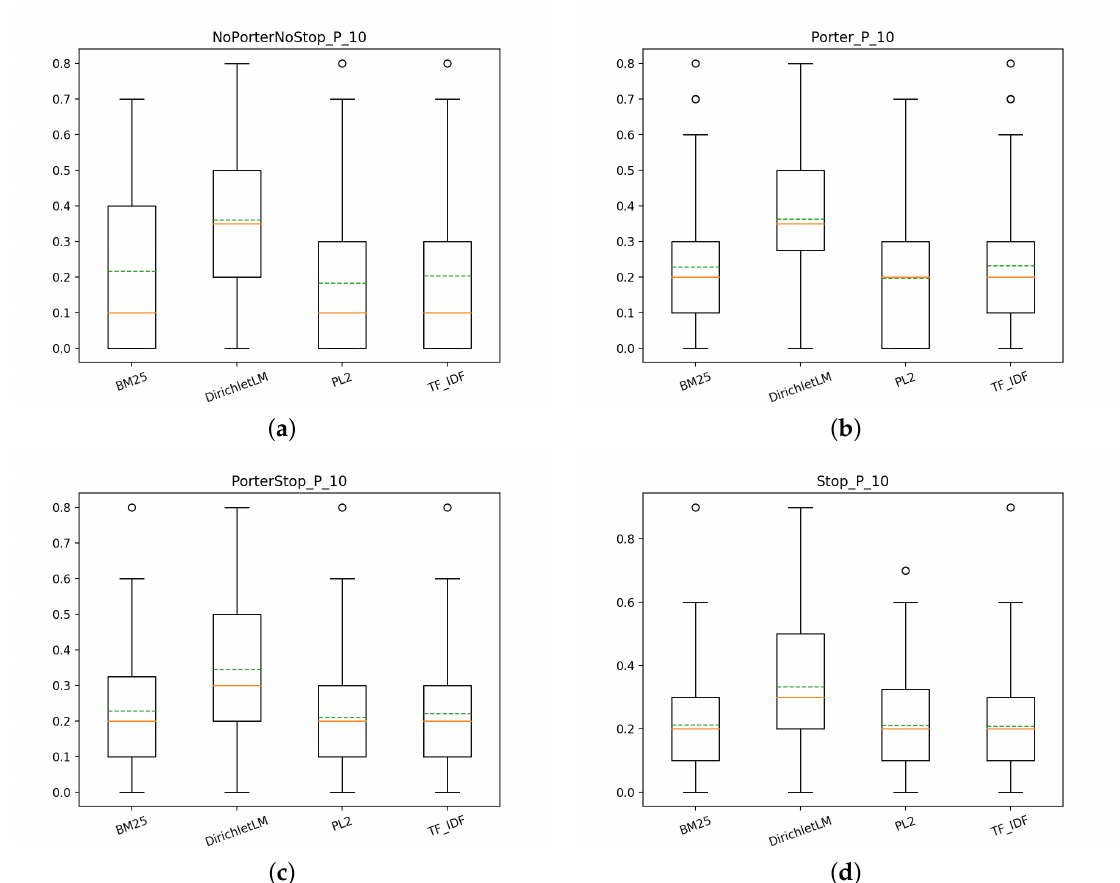
Figure 8. T1: box plots for P@10 of the different models for each index, with query expansion (QE) and relevance feedback (RF): ( a ) NoPorterNoStop indexs, ( b ) Porter index, ( c ) PorterStop index, ( d ) Stop